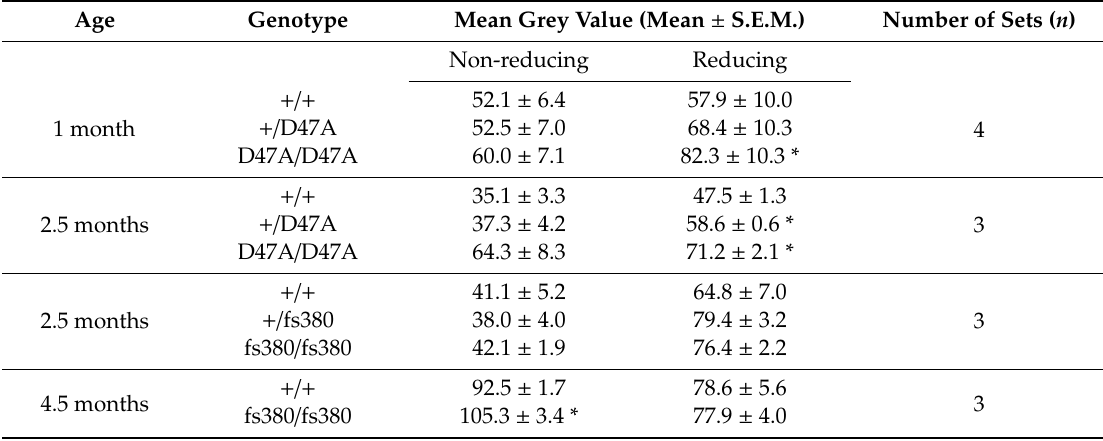
Table 2. High molecular weight protein content under non-reducing and reducing